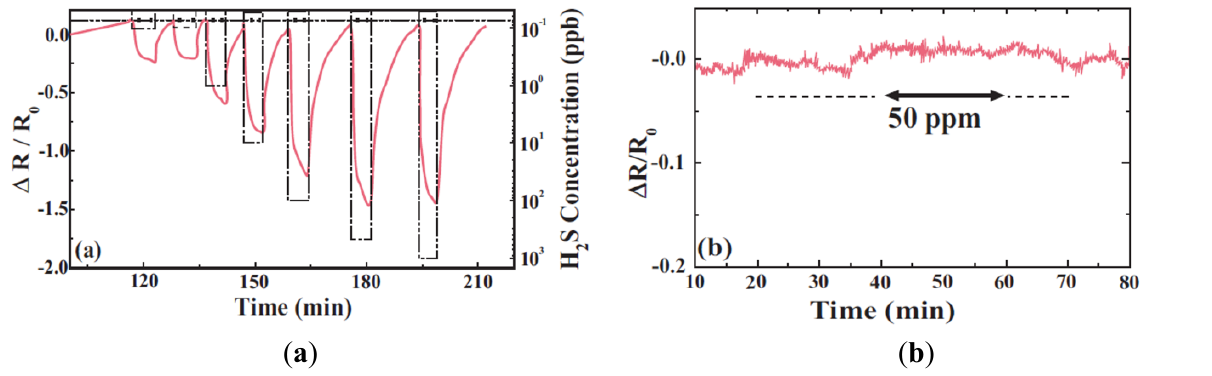
Figure 26. ( a ) Response and recovery transients of gold nanoparticles functionalized PANI nanowire network-based chemiresistive sensor toward 0.1 ppb, 1 ppb, 10 ppb, 100 ppb, 500 ppb, and 1 ppm concentrations of H 2 S gas; ( b ) Response of non-functionalized PANI nanowire network toward 50 ppm of H 2 S gas. (Reproduced with permission from [116], Copyright AIP Publishing LLC